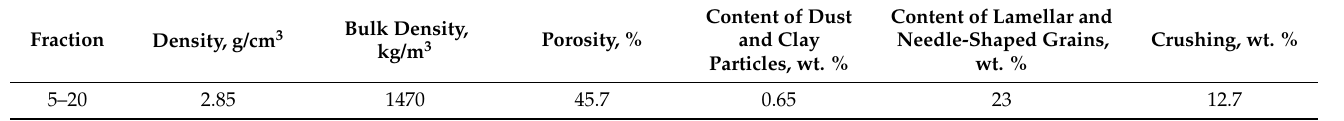
Figure 1. Crushed granite ( a ) used as a large aggregate and slag pumice ( b ) used as a combined aggregate. The physical and mechanical characteristics of which are presented in Table 3. Table 3. Physical and mechanical characteristics of crushed stone.